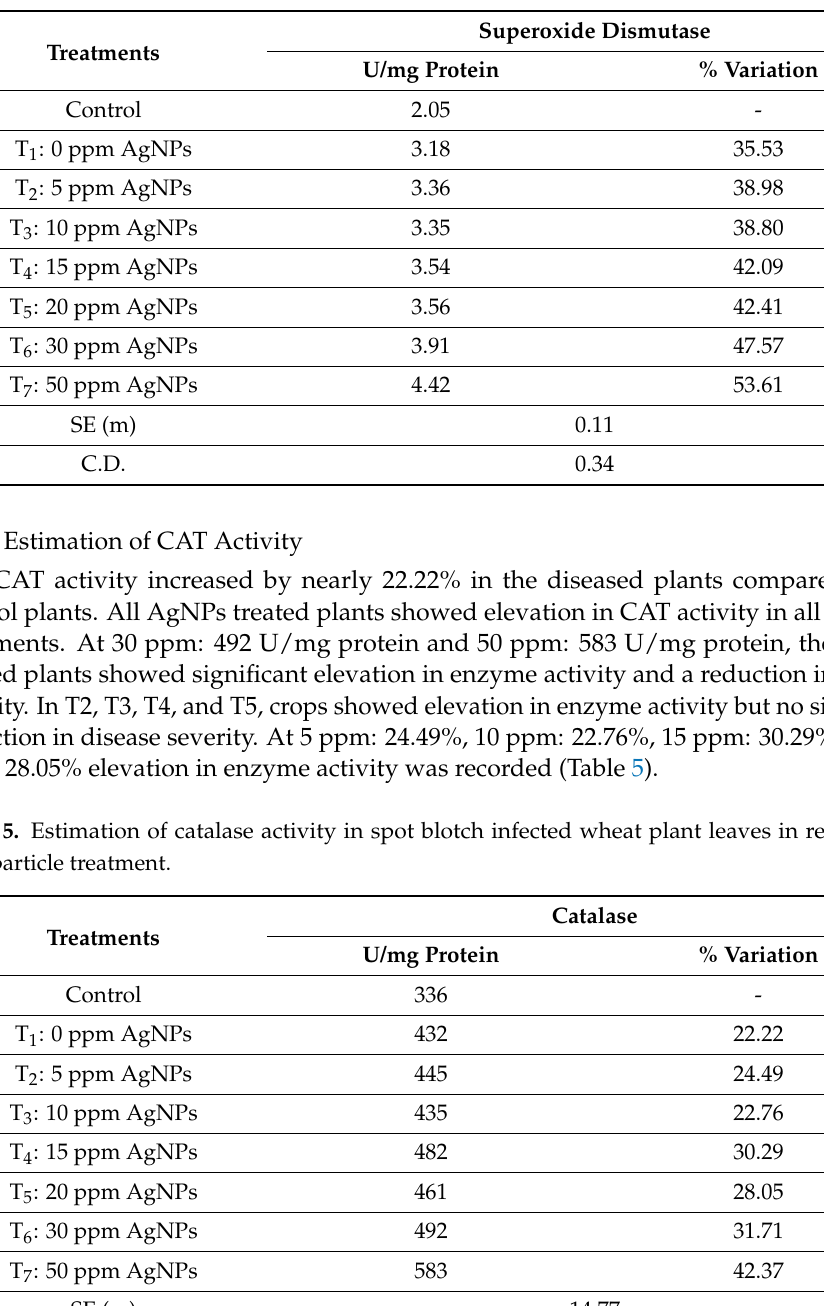
Table 4. Estimation of Superoxide dismutase activity in spot blotch infected wheat plant leaves in response to nanoparticle treatment.